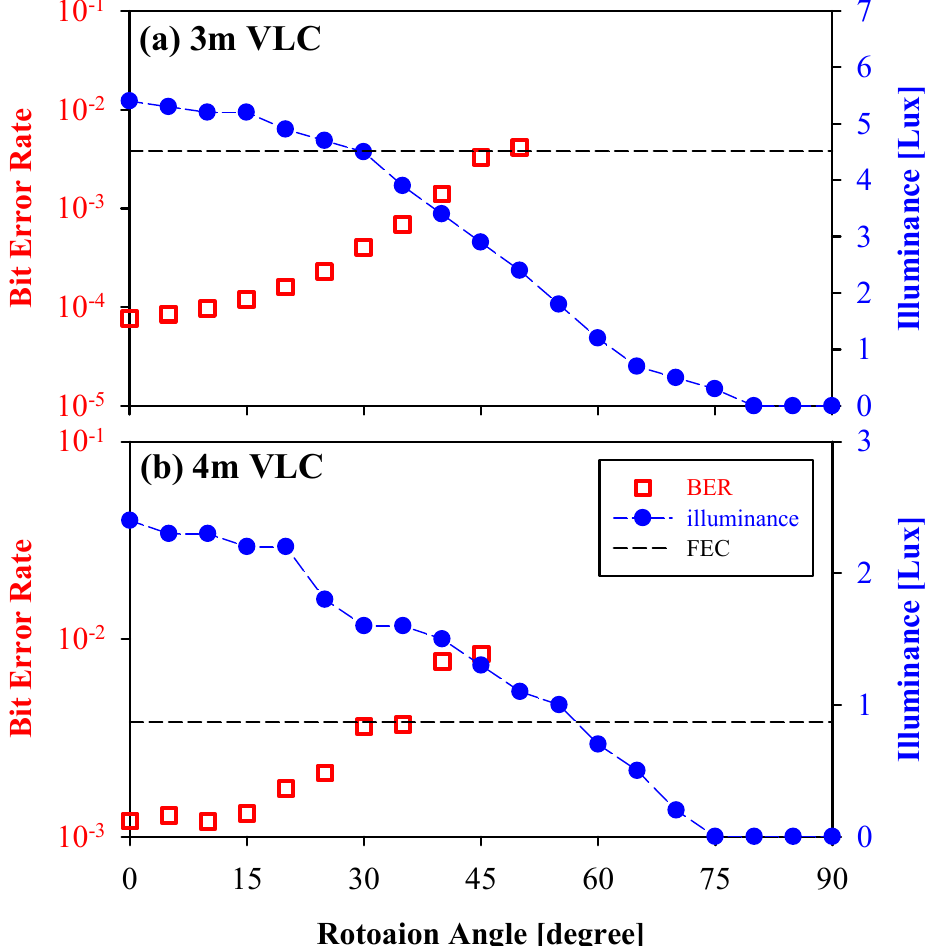
Figure 7. VLC (Blus) BER measurements of 620 and 440 Mbps after the free space link of ( a ) 3 and ( b ) 4 m under different corresponding illuminance.